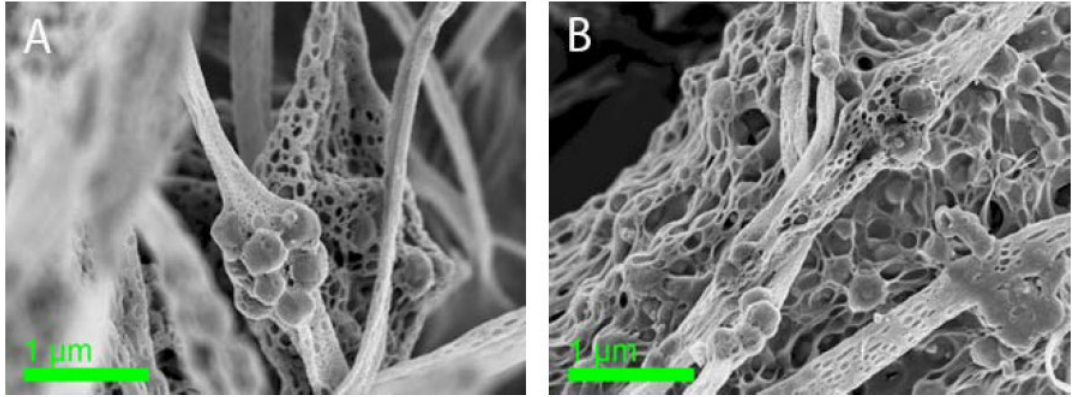
Figure 3. SEM image of LTA aggregates within electrospun CA fibers from solutions without uniform dispersion of LTA. ( A ) Small LTA aggregates can be seen within the fiber; ( B ) while larger aggregates of polymer-coated LTA can be seen.